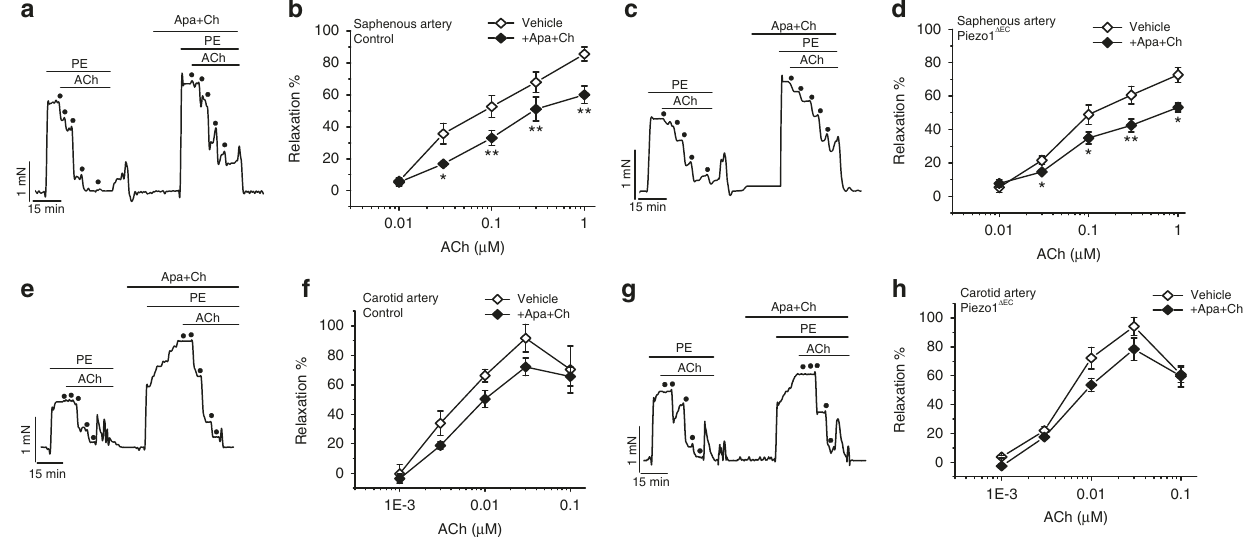
Fig. 8 Contribution of endothelial Piezo1 is vascular bed speci fi c. Isometric tension recordings from mouse saphenous or carotid artery. a Example recordings from control genotype saphenous artery before and after application of apamin (Apa, 0.5 μ M) and charybdotoxin (Ch, 0.1 μ M). Phenylephrine (PE, 0.3 μ M). Acetylcholine (ACh) was applied at increasing concentrations as indicated by the dots (0.01, 0.03, 0.1, 0.3 and 1 μ M). b As for a but mean data ( n = 5 mice). c , d As for a , b but for Piezo1 Δ EC mice ( n = 5 mice). e – h As for a – d but carotid artery ( n = 5 control mice, n = 5 Piezo1 Δ EC mice). Averaged data are displayed as mean ± s.e.m. Data sets are compared by t -test. Statistical signi fi cance is indicated by * P < 0.05, ** P <